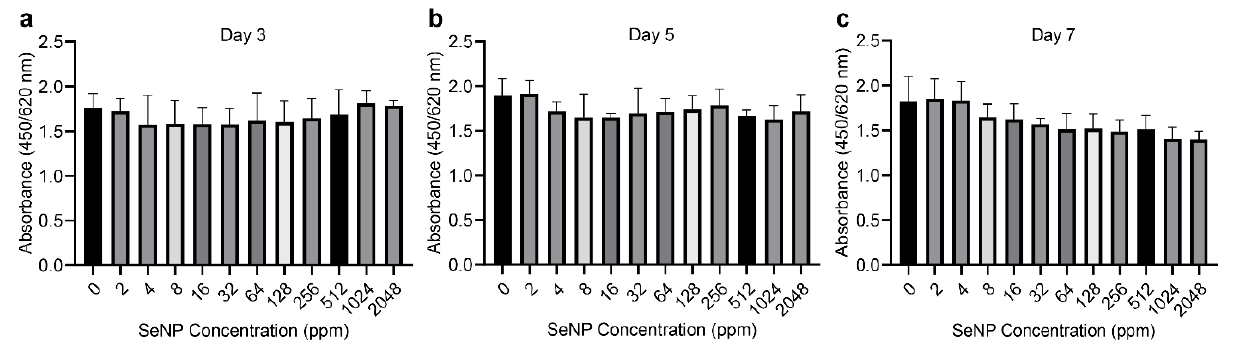
Figure 2. Effect of selenium nanoparticles (SeNPs) on cell viability on ( a ) day 3, ( b ) day 5, and ( c ) day 7. MC3T3 cells were cultured together with SeNPs for up to 7 days. Cell viability was measured using the Cell Counting Kit-8 (CCK-8) after 60 min of culture in CCK-8 solution. From days 3 to 7, an apparent decrease in cell viability could be observed, but it was not significantly different from that of SeNPs of 0 ppm (=mg/L) (control group). SeNPs concentration did not significantly affect cell viability. Data are expressed as mean ± standard deviation, n = 4. (*: p < 0.05, **: p < 0.01).